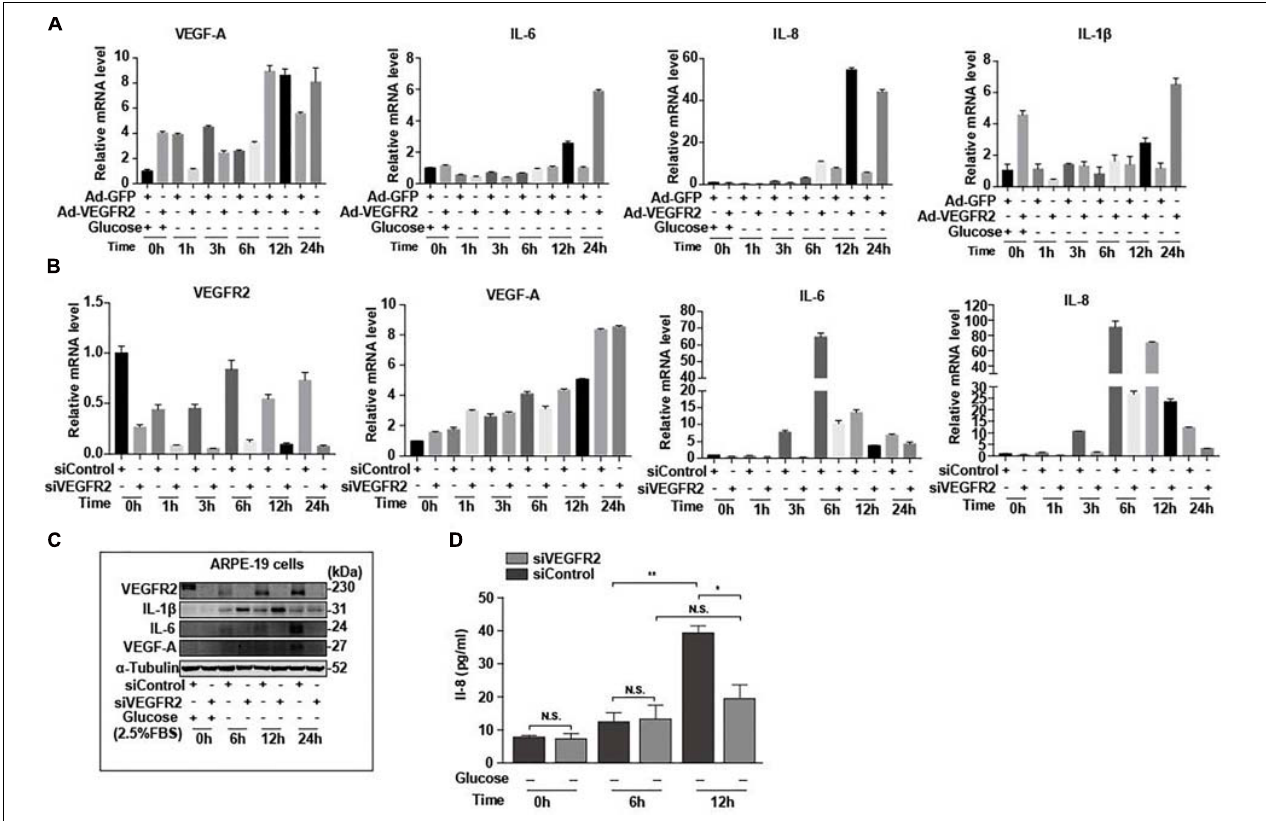
FIGURE 7 | Level of VEGFR2 determined inflammation under glucose deprivation. (A) Overexpression of VEGFR2 increased expression of inflammatory factors at the RNA level. (B) VEGFR2 knockdown decreased expression of inflammatory factors at the RNA level. (C) VEGFR2 knockdown changed expression of inflammatory factors at the protein levels. (D) VEGFR2 knockdown decreased IL-8 expression measured by ELISA. All error bars indicate S.D. * P < 0.05, ** P < 0.01, *** P < 0.001, **** P <